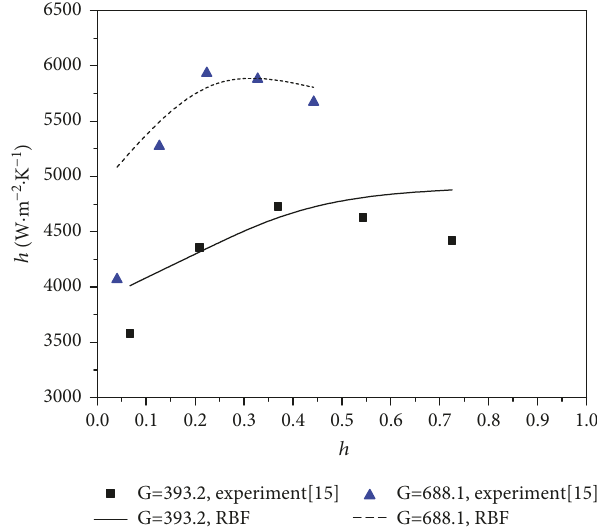
Figure 6: When the evaporation temperature is 50 ° C, the heat transfer coe ffi cient of R245fa changes with quality of vapor-liquid mixture and mass fl ux